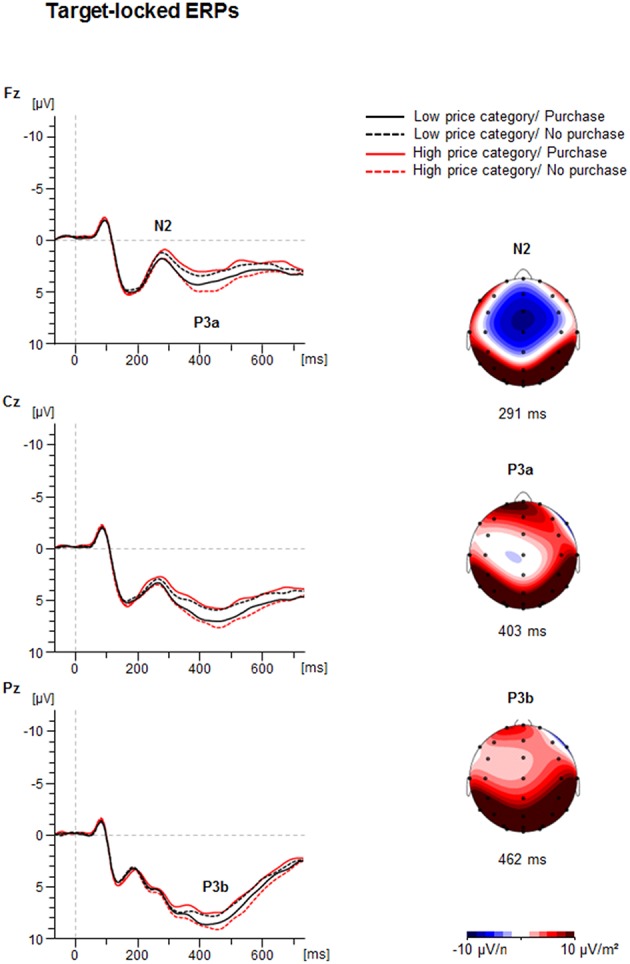
Target-locked ERP-waveforms as a function of Price Category (low, high) and Purchase Decision (purchase, no purchase) at electrodes Fz, Cz, and Pz. Dashed vertical line indicate price-onset (0 ms). The Current Source Density maps (CSDs) illustrate a mean activity distribution for the N2 at 291 ms, for the P3a at 403 ms, and for the P3b at 462 ms. Note, the amplitude of the grand average does not necessarily match the amplitude of the peak amplitudes presented in the diagrams (c.f. Figure 4). The generally lower amplitude values in the grand average are due to individual latency jitter of components which reduce its amplitude after grand averaging relative to the peak analysis used for statistics. In contrast, the amplitude diagrams represent the mean of individual maximal or minimal peak amplitudes at the individual latency.